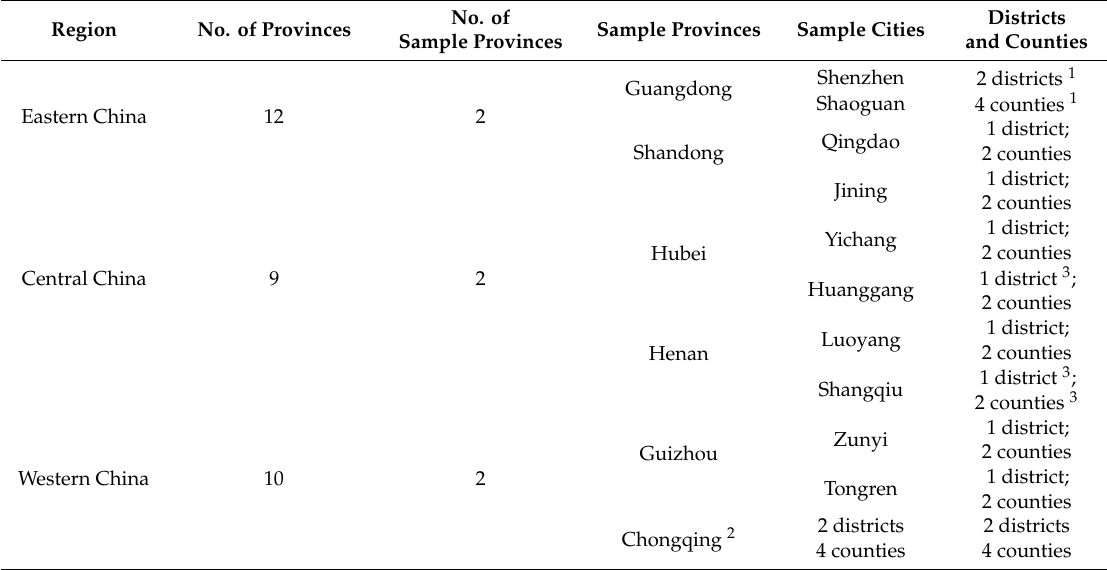
Table 1. Study sample of primary care